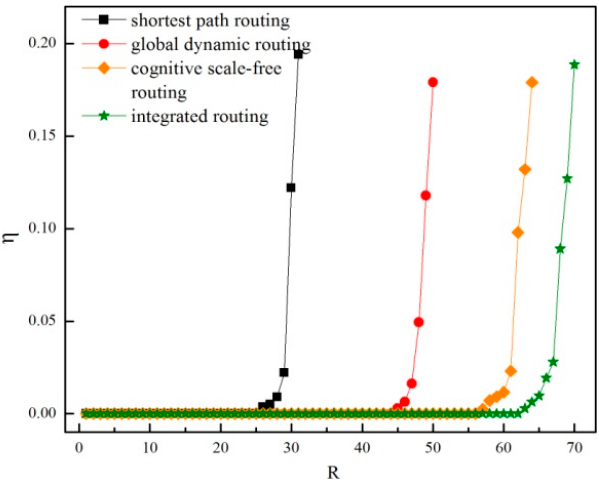
Figure 13. The order parameter η vs. R under the four routing strategies.